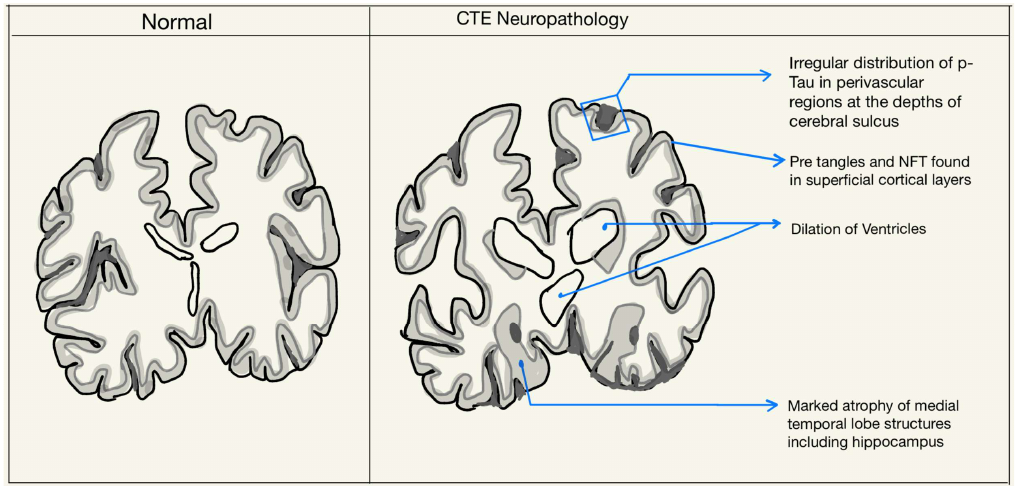
Figure 2. Neuropathological features in the diagnosis of CTE.